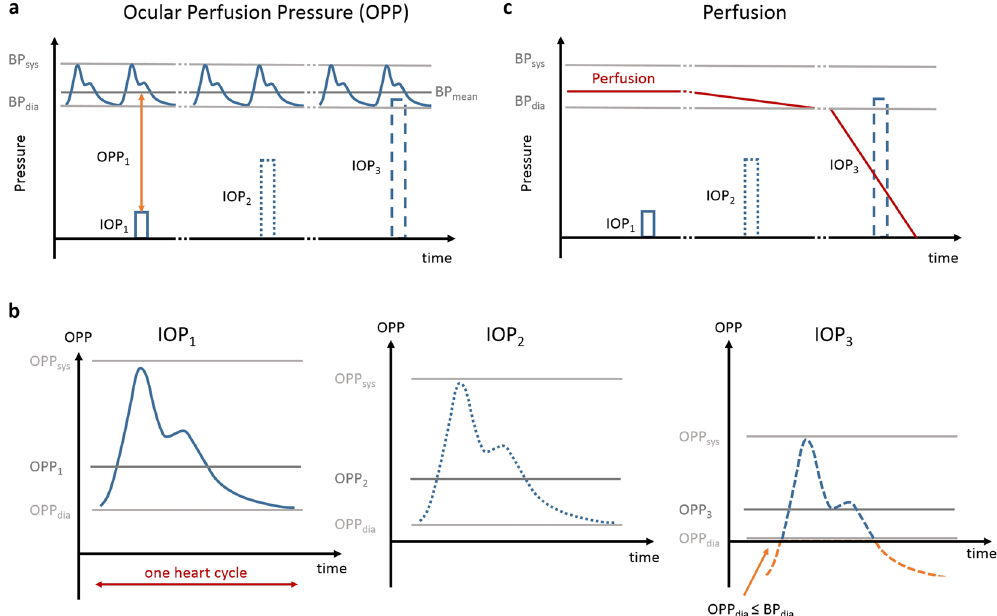
Figure 7. Model of the ocular perfusion pressure (OPP) and perfusion changes during IOP elevation. ( a ) An elevation of the IOP will cause a decrease in the mean OPP. ( b ) The pressure amplitude defined as the difference between the systolic and diastolic pressure level remains unchanged until the diastolic OPP undercuts the diastolic blood pressure. ( c ) The ocular perfusion will stop at this threshold and hence the fundus pulsations will vanish as